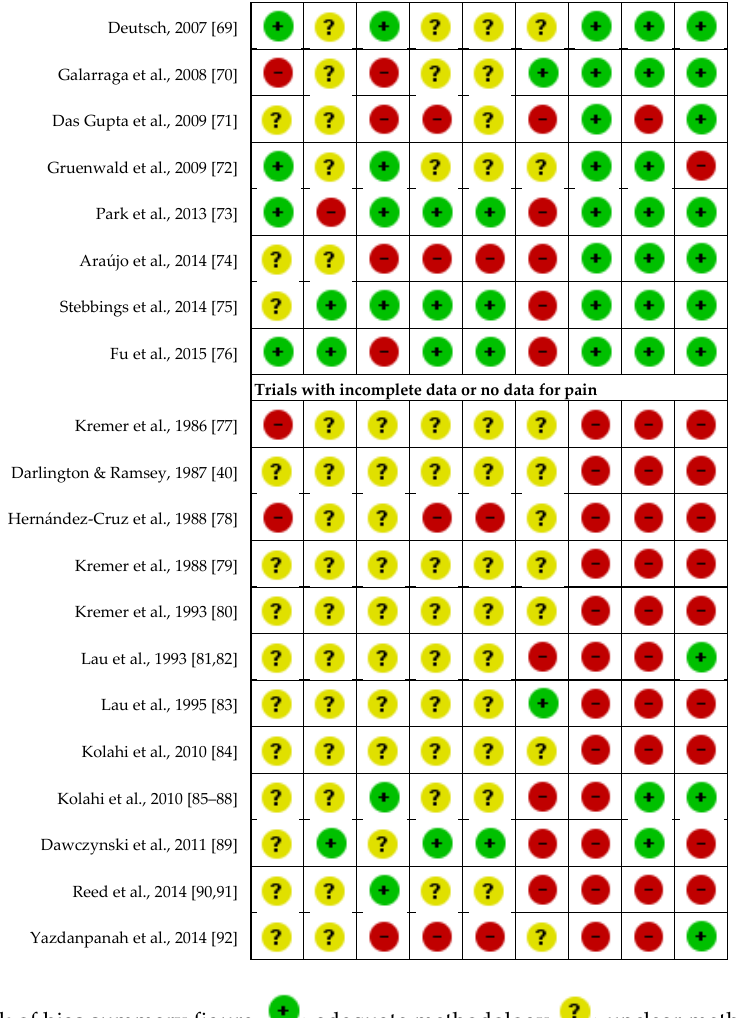
Figure 2. Risk of bias summary figure. : adequate methodology, : unclear